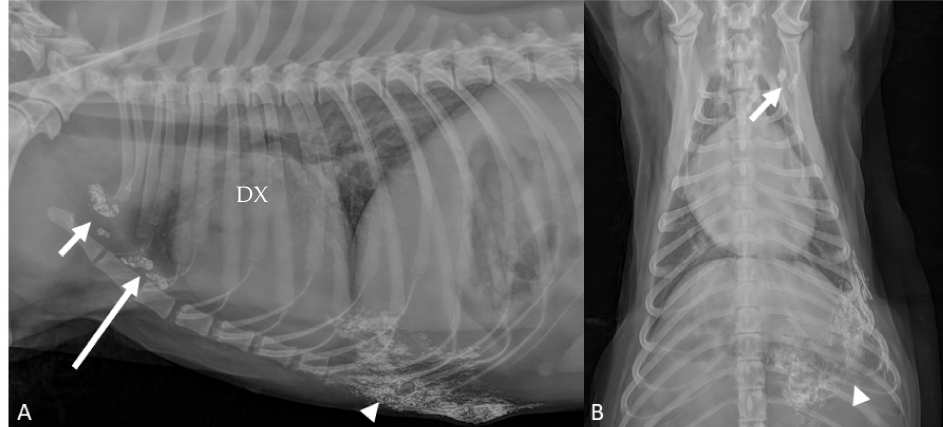
Figure 2. ( A , B ) Cocker Spaniel 10 yr (Case #10). Right lateral and ventro-dorsal radiographic projections of the thorax. Third mammary gland surrounded by lipiodol (arrowheads): ipsilateral accessory axillary (( A )—long arrow) and a in axillary (( A , B )—short arrows) lymph nodes were